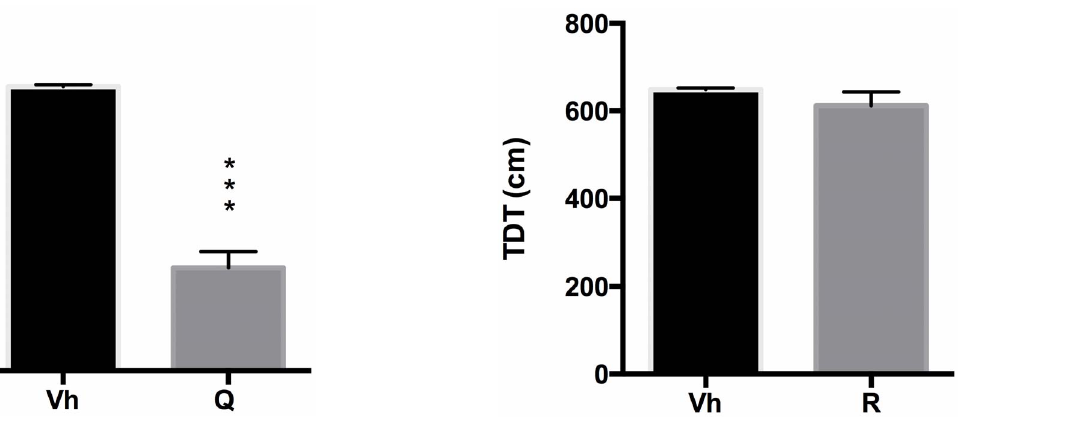
Figure 6. Quinpirole and OF. Effect of quinpirole on the total distance travelled (TDT) in the open field arena. ***p , 0.001 Vs Vh.